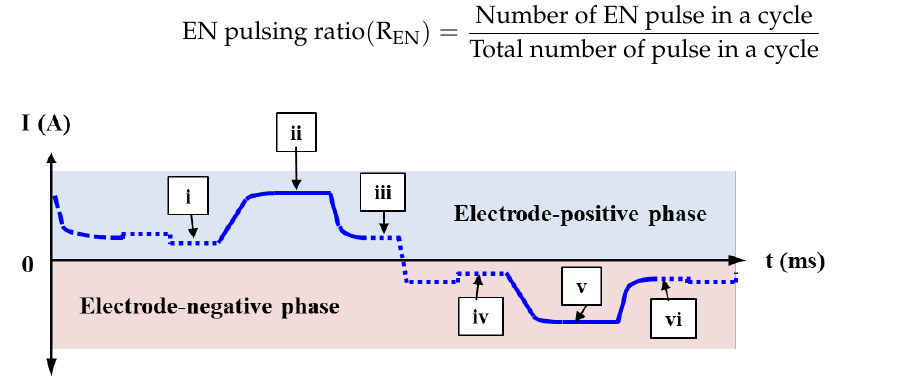
Figure 2. Schematic of current waveform used in the experiment. Table 3. Current parameters applied to yield the results shown in Figure 3.